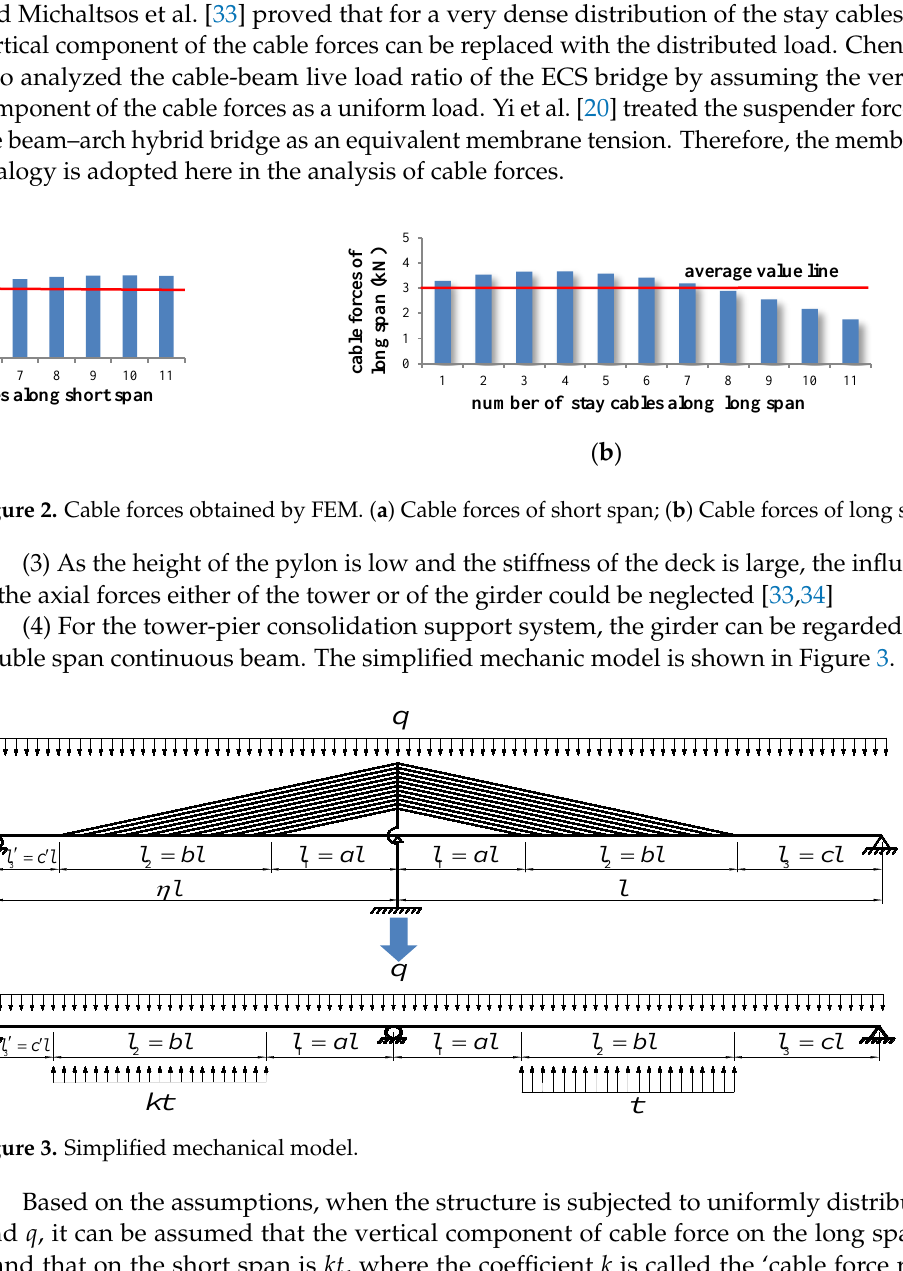
Figure 1. Configuration of the basic model (unit: cm).